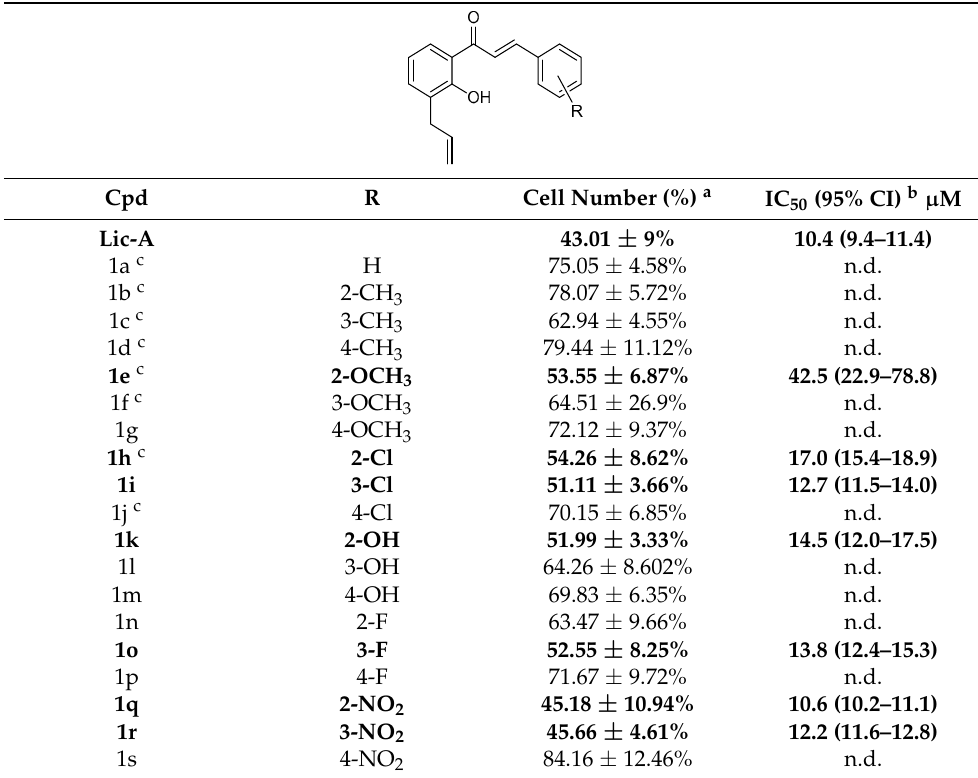
Table 1. Structure of studied compounds 1a – s , cell growth inhibition data, and IC 50 values of selected compounds.